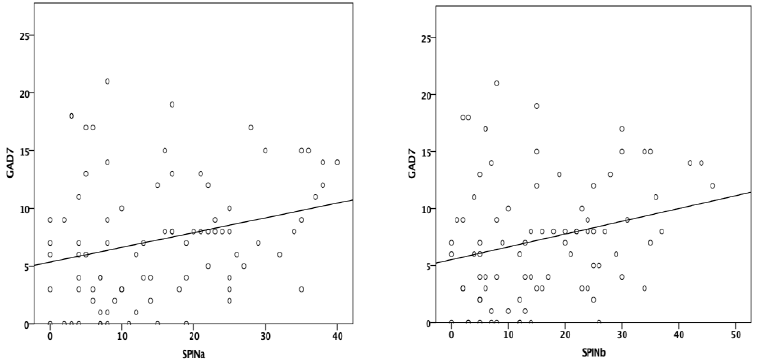
Figure 5. Correlation between the SPIN and GAD-7 (SPINa — initial evaluation; SPINb — follow-up evaluation).